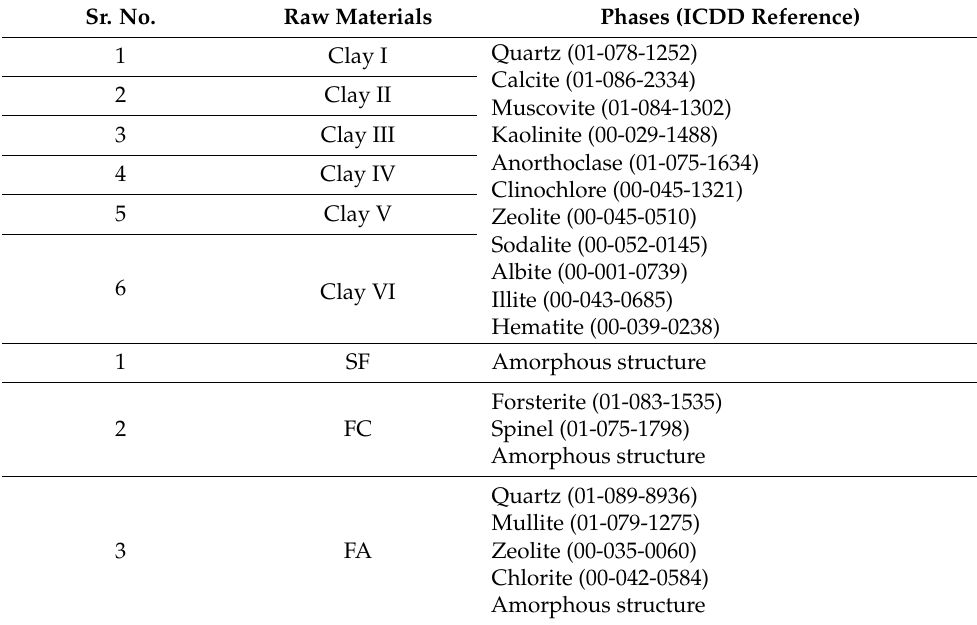
Table A1. ICDD reference for the peaks in XRD patterns of raw materials. Sr.